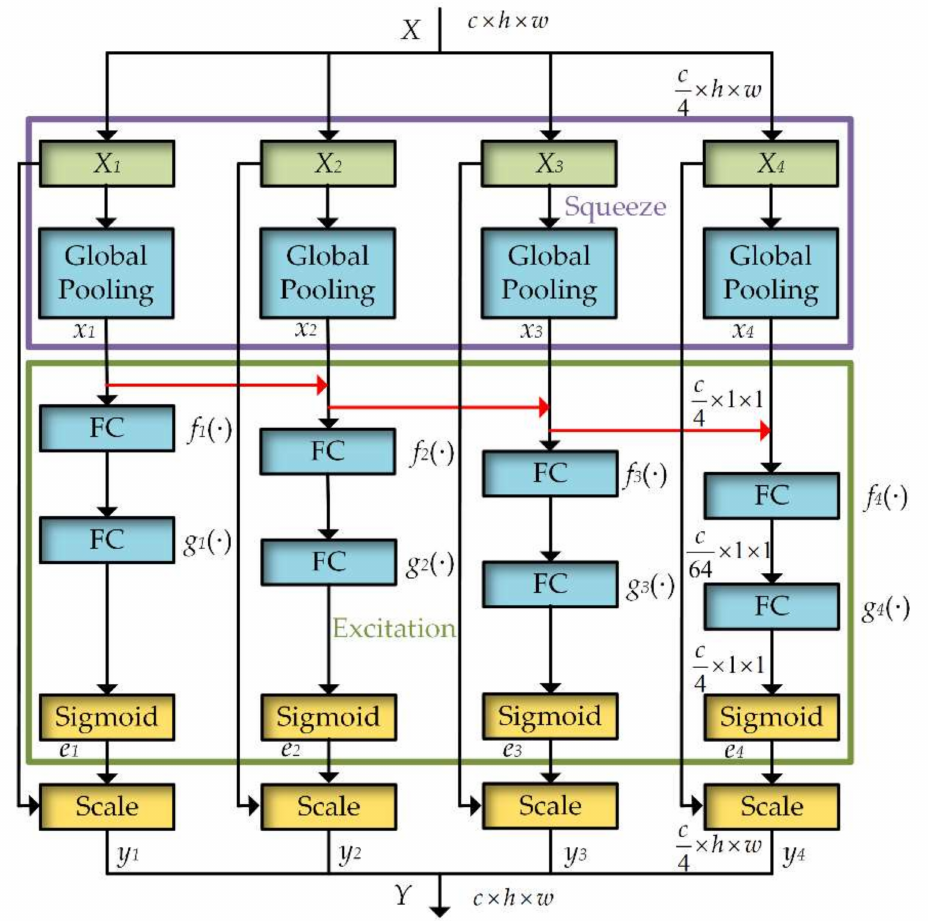
Figure 6. The architecture of the OSEM. The purple frame indicates the squeeze operation, and the green frame indicates the excitation operation. FC denotes the fully connected layer. For each feature block, the number of neurons in the first and second fully connected layer is set to c / 64 and c / 4. The input is denoted by X , and the output is indicated as Y